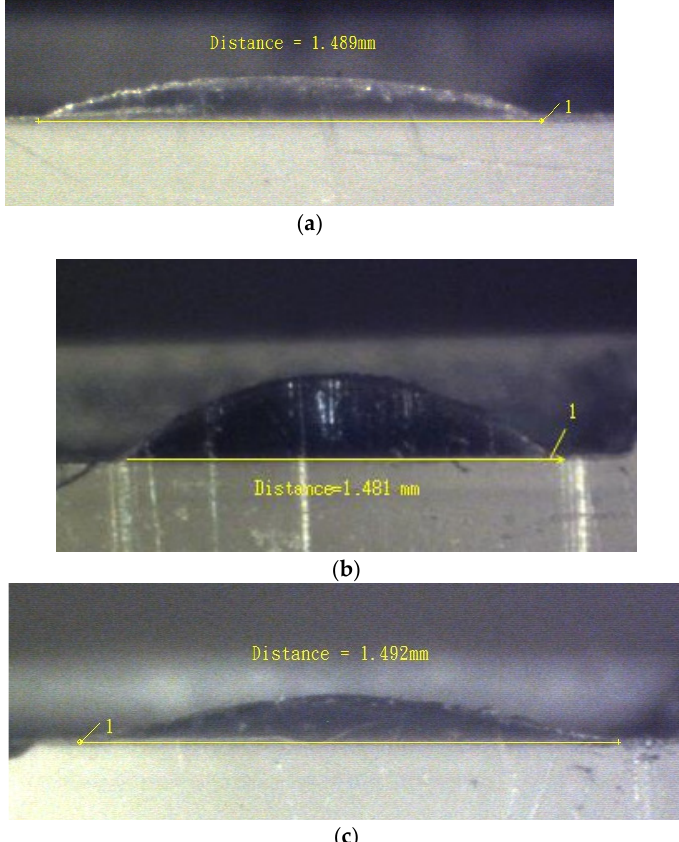
Figure 8. Cross section of conic section of micro-aspherical lenses fabricated by the microshaper scraping. ( a ) Oblate ellipsoid ( R = 3 mm, k = 10), ( b ) paraboloid ( R = 1 mm, k = − 1), and ( c ) hyperboloid ( R = 1 mm, k = − 20).